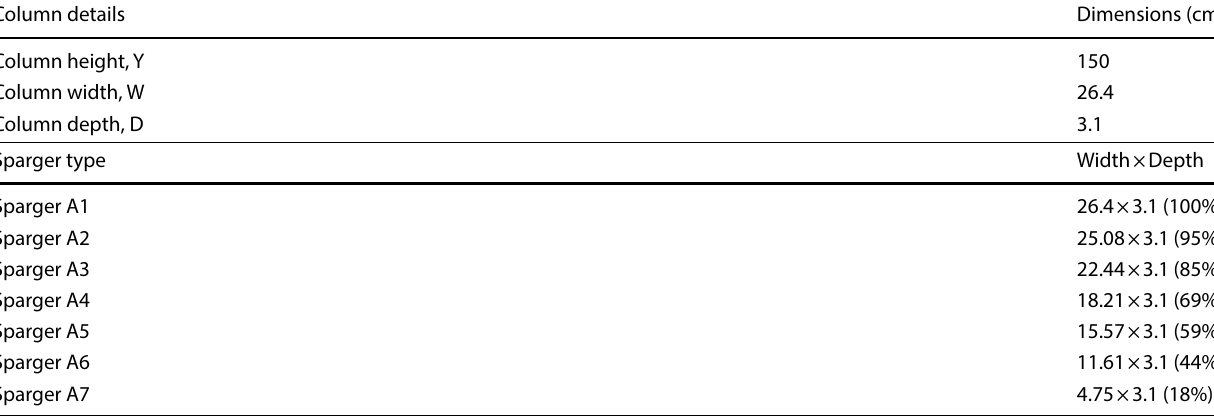
Table 2 Dimensions of the bubble column and sparger used for the main study Column